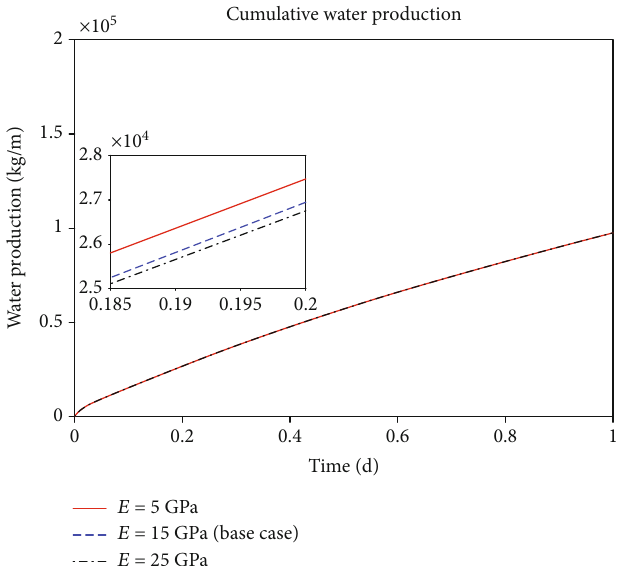
Figure 18: Cumulative water production at the wellbore during one day of shallow water fl ow for Young ’ s modulus sensitivity.